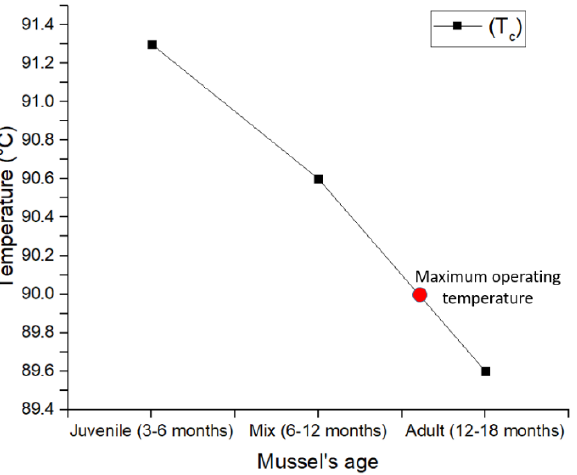
Figure 16. DSEC conductor temperature in function of mussel age.